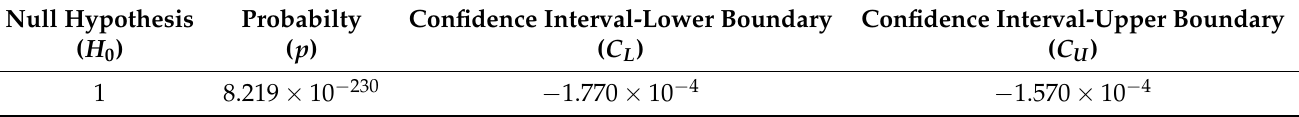
Table 3. Two-sample t -test on PCA features extracted from real-parts of MammoWave’s S 21 data.